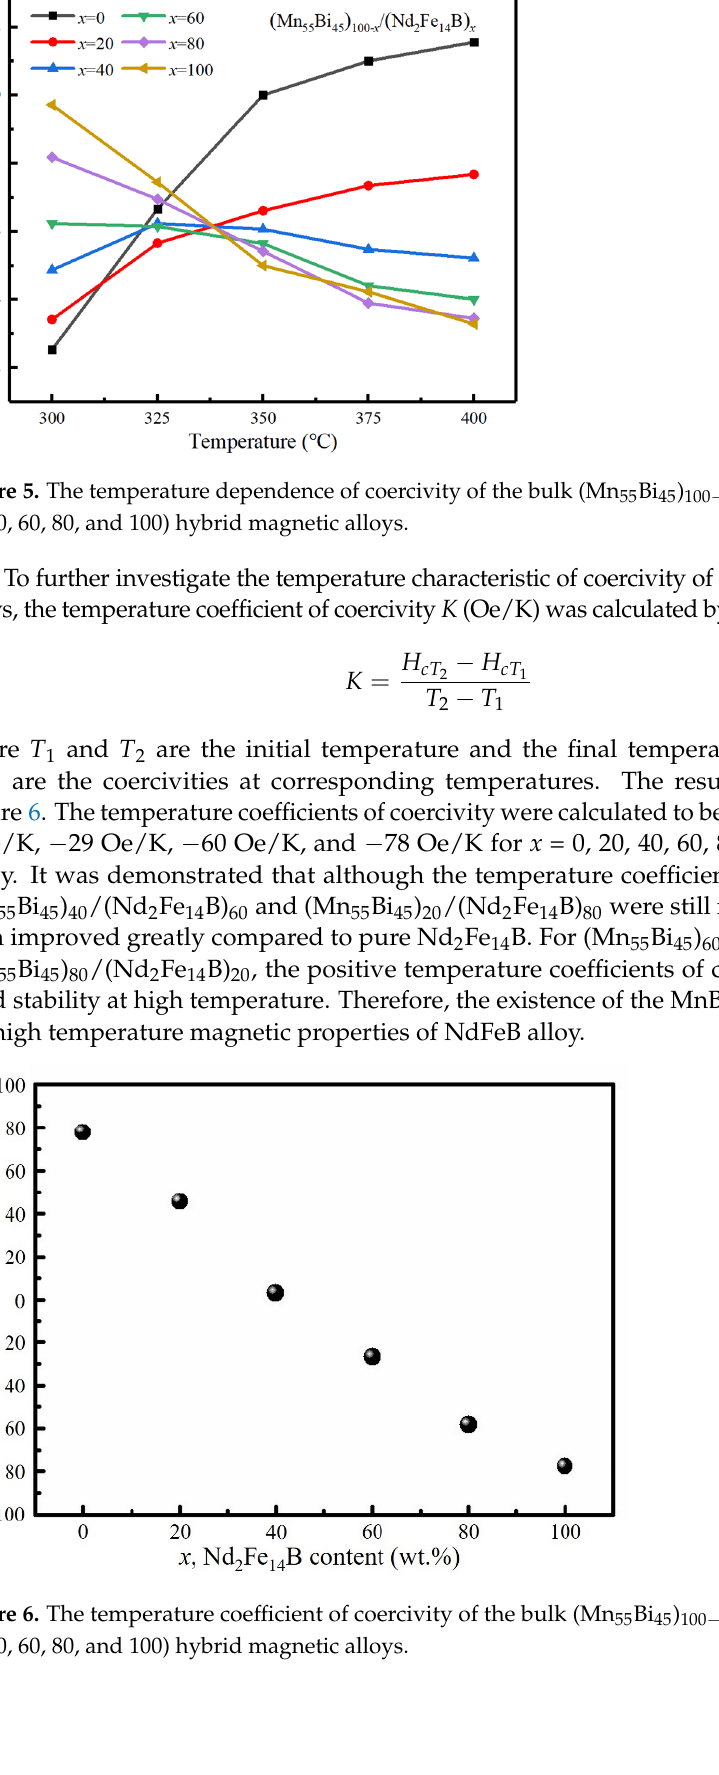
Figure 6. The temperature coefficient of coercivity of the bulk (Mn 55 Bi 45 ) 100 − x /(Nd 2 Fe 14 B) x ( x = 0, 20, 40, 60, 80, and 100) hybrid magnetic alloys.